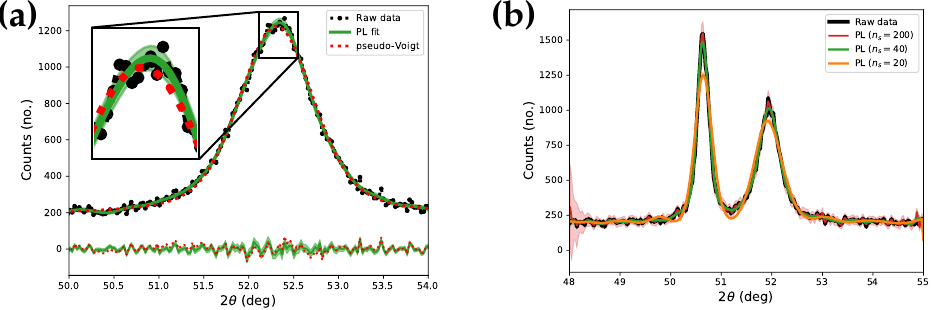
Figure 1. Example of the smoothing and fitting schemes. ( a ) Shows the differences between a traditional pseudo-Voigt and the PL smoothing for the as milled powder. The error for each fit is shown below the pattern. The green bands correspond to the PL 95% confidence interval. ( b ) Shows the influence of the number of spline segments on the goodness of fit. Too many segments lead to over fitting, while too few does not capture the proper pattern shape. Note that for n s = 200, the 95% confidence interval quickly grows towards the beginning of the